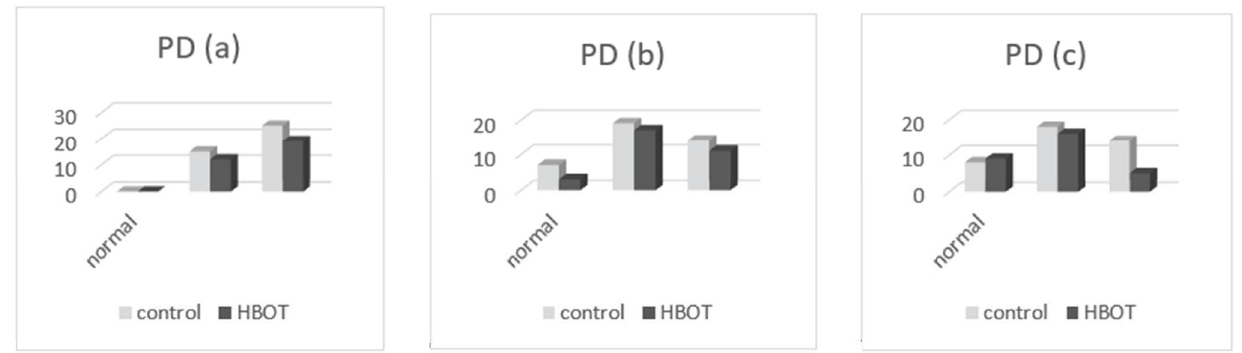
Figure 6. Patient distribution based on DM index at ( a ) first examination, ( b ) second examination, and ( c ) third examination.